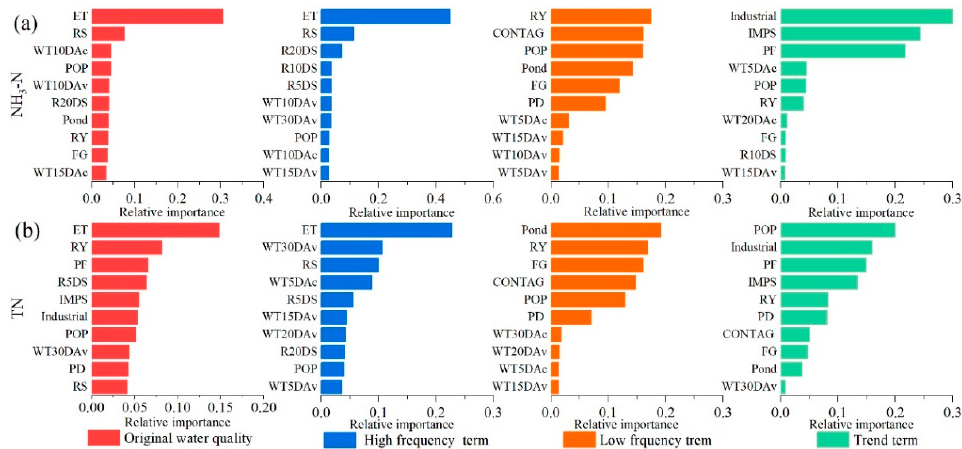
Figure 7. The relative importance of the driving factors. The R5DS, R10DS, R20DS, RS, and RY represent the sum rainfall over 5 days, 10 days, 20 days, seasonally, and yearly. The WT5DAc, WT10DAc, WT15DAc, WT20DAc, and WT30DAc indicate the cumulative magnitude of change in the lake water table over 5 days, 10 days, 15 days, 20 days, and 30 days. The WT5Av, WT10Av, WT15Av, WT20Av, and WT30Av indicate the average lake water table over 5 days, 10 days, 15 days, 20 days, and 30 days. FG represents forest/grassland. POP represents the population. IMPS indicates impervious surface.